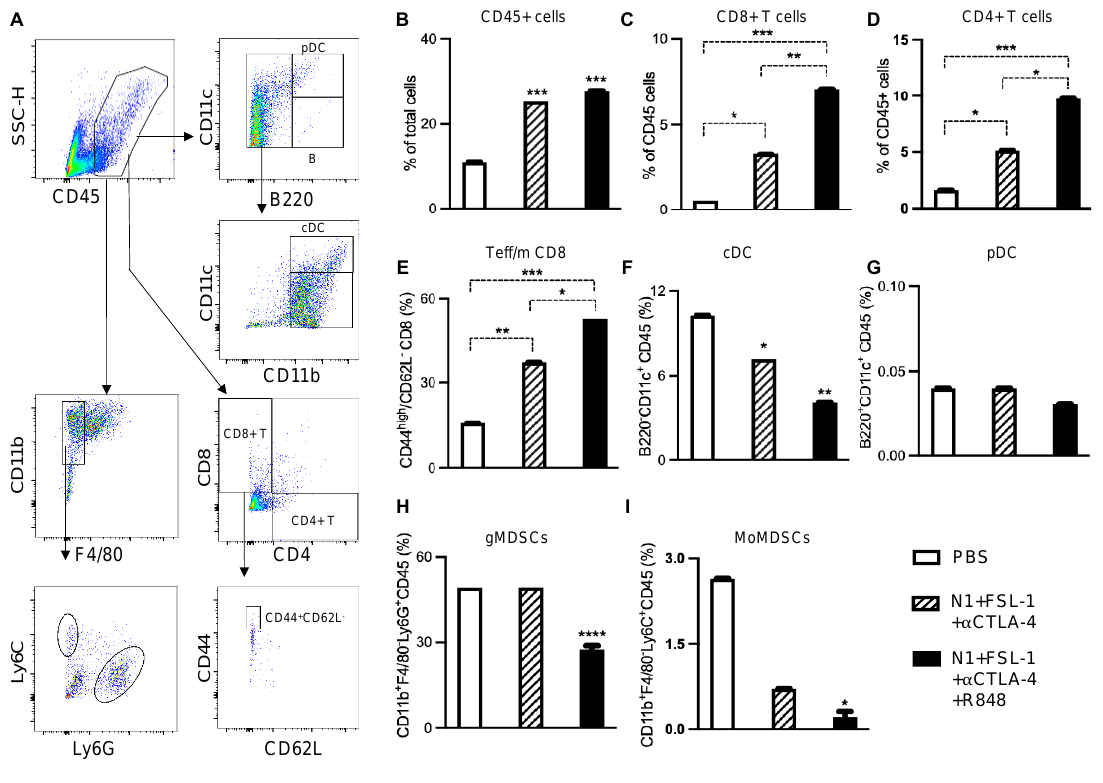
Figure 4. The effective combined immunotherapeutic regimens enhanced the immune activation in 4T1 mammary carcinoma model. Flow data were analyzed as in ( A ). Quantification of flow cytom- etry data showing elevated tumor infiltration of CD45+ leucocytes ( B ), CD8+ T cells ( C ), CD4+ T cells ( D ), and effector/memory CD8+ T cells (CD44highCD62L- CD8+ T cells ( E ), as well as reduced levels of infiltration of conventional dendritic cells (cDC; CD45+CD11c+B220- cells ( F ), granulocytic MDSCs (gMDSCs, CD45+CD11b+Ly6GhighLy6Clowcells ( H ), and monocytic MDSCs (Mo-MDSCs, CD45+CD11b+Ly6Glow Ly6Chigh (pDC; CD45+CD11c+B220+ cells) in the tumor did not change in response to the combined immunothera- peutic regimens ( G ). Data are shown as mean ± SEM (n = 5). * p < 0.05; ** p < 0.01; *** p < 0.001; and **** p < 0.0001.